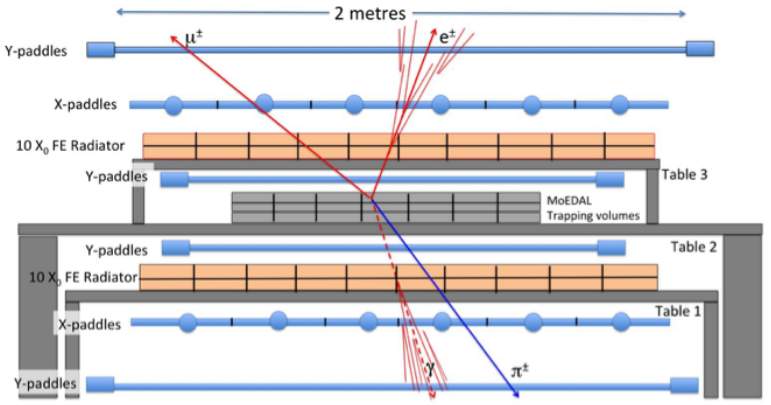
Figure 10. A sketch of the MALL sub-detector proposed for